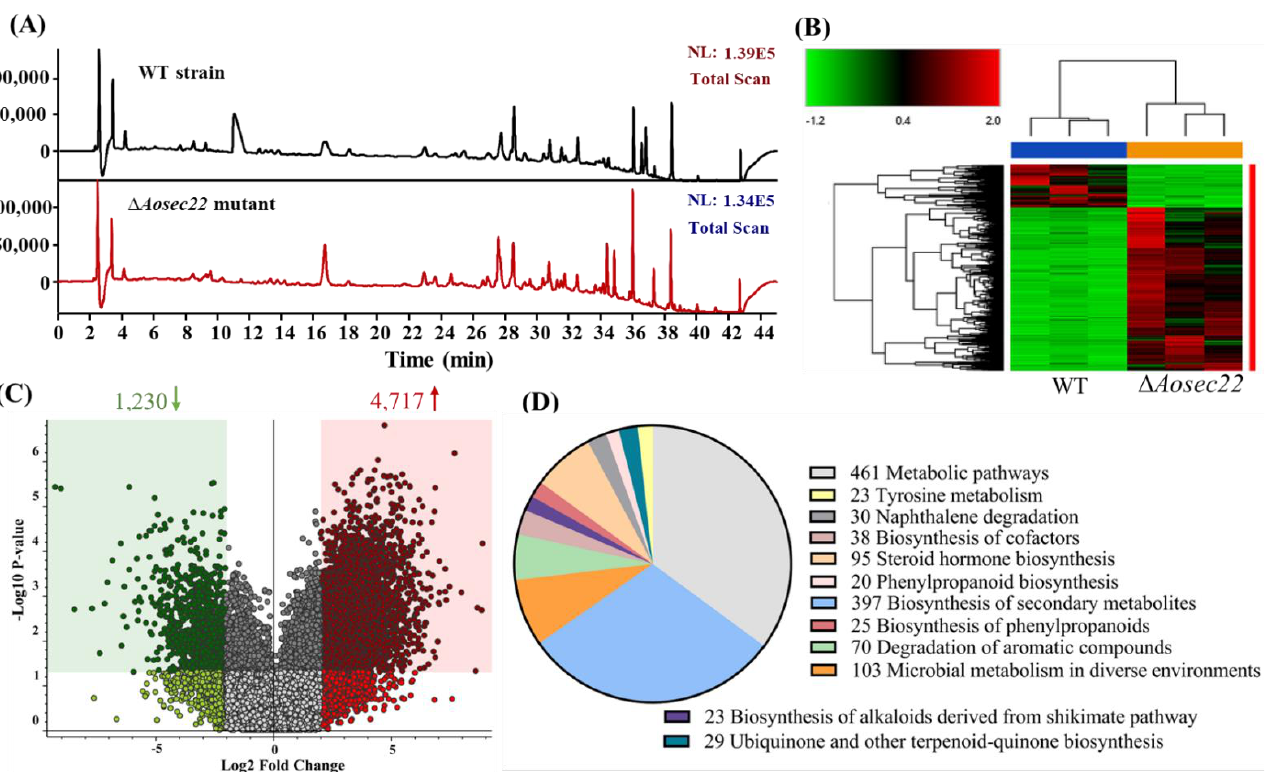
Figure 7. Comparison of metabolic profiling between WT and ∆ Aosec22 mutant strains. ( A ) Comparison of high-performance liquid chromatography profiles of the WT and ∆ Aosec22 mutant strains. ( B ) Heatmap for upregulated and downregulated metabolic pathways between ∆ Aosec22 mutant and WT strains determined via KEGG enrichment. ( C ) Volcano plot of differential metabolites between ∆ Aosec22 mutant and WT strains. ( D ) The number of downregulated and upregulated KEGG pathways in Δ Aosec22 mutant.